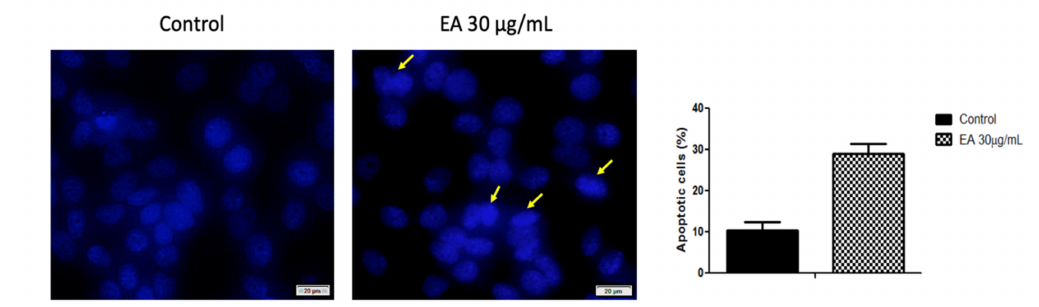
Figure 5. The effect of 30 µ g/mL of EA on MCF-7 cells’ nuclei after 72 h. Morphological changes distinctive for apoptosis induction are marked with yellow arrows. For the nuclear visualization, DAPI staining was performed. The scale bars represent 20 µ